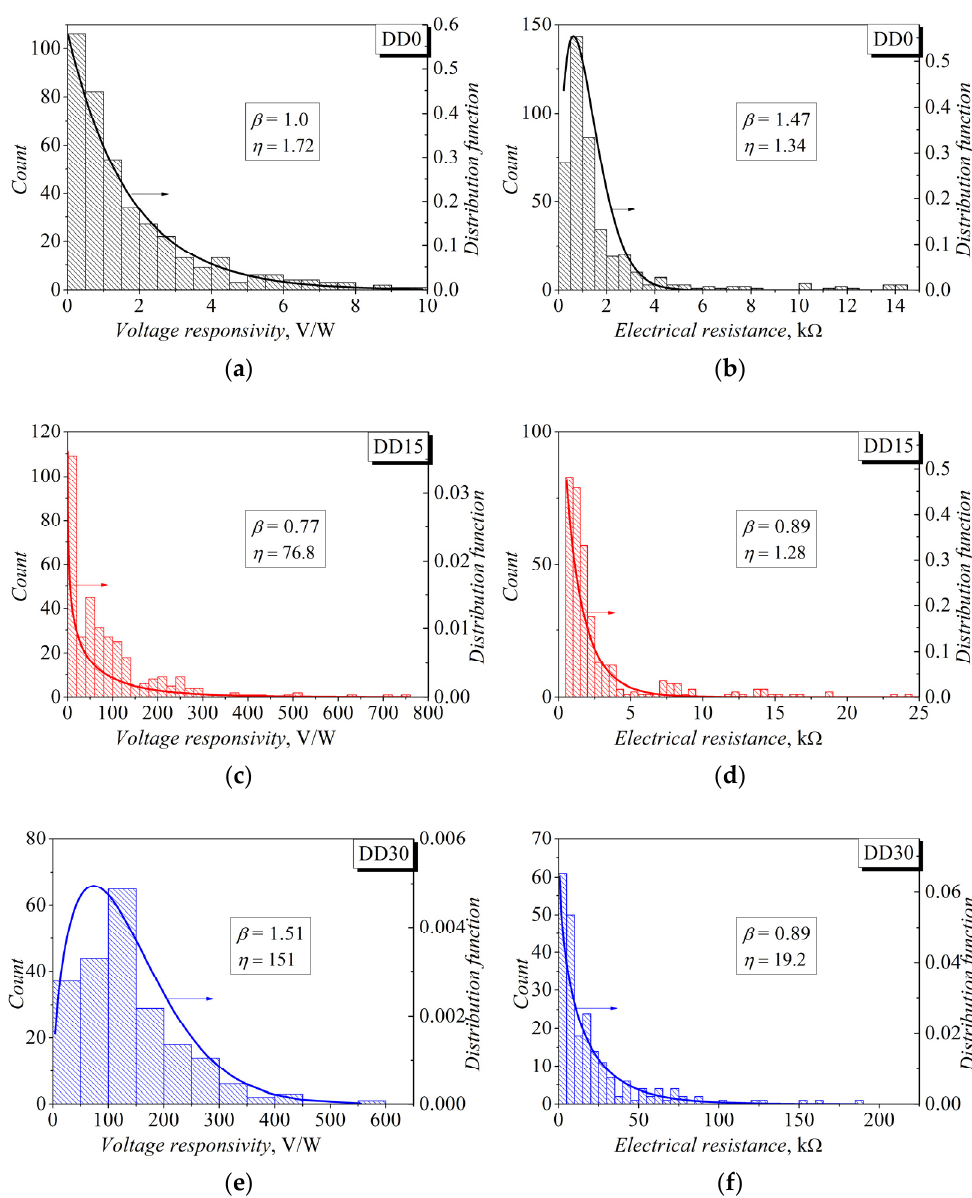
Figure A2. Histograms of the voltage responsivity ( a , c , e ) and electrical resistance ( b , d , f ) experimental data of the diodesw DD0 ( a , b ); DD15 ( c , d ); DD30 ( e , f ) approximated with Weibull distribution function.